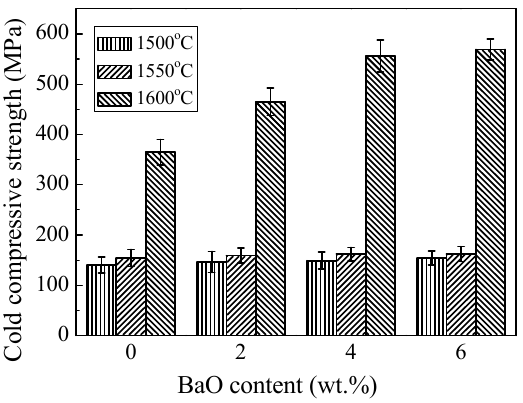
Figure 5. Cold compressive strength of the samples as a function of BaO addition and sintering temperature.